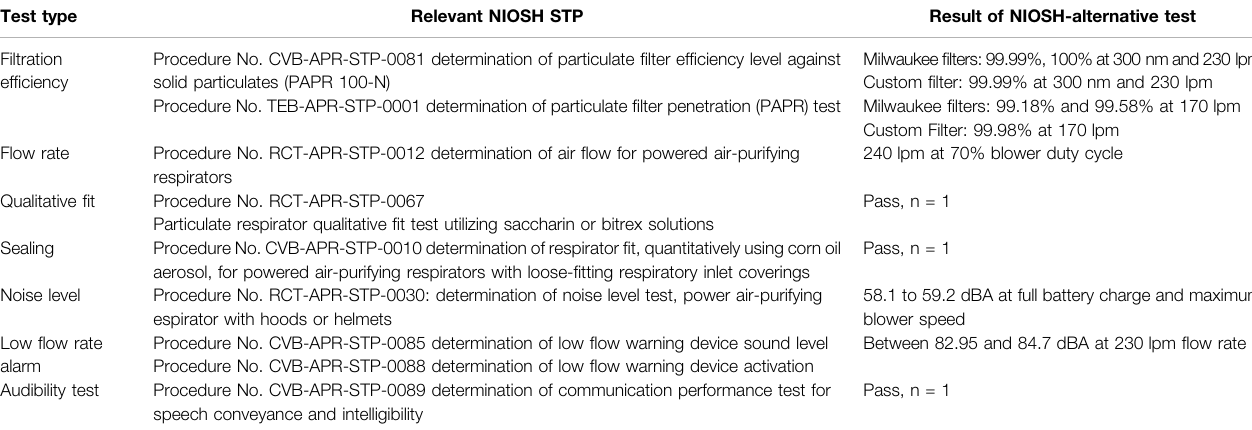
TABLE 2 | PanFab PAPR component validation test type, regulatory guidance, and alternative test results. Full STPs available as Supplementary Material 1 . Test type